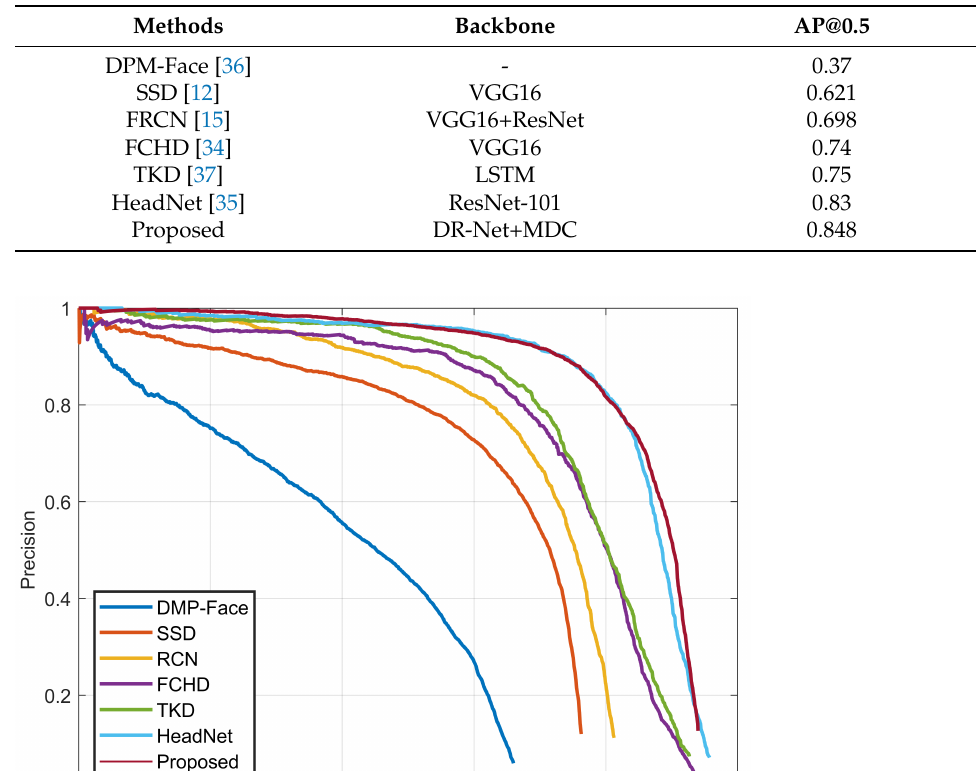
Figure 9. The PR curves of our method versus other methods from the experiments on the Brain- wash dataset. Table 7. Results of our method compared with other methods on the HollywoodHeads dataset.